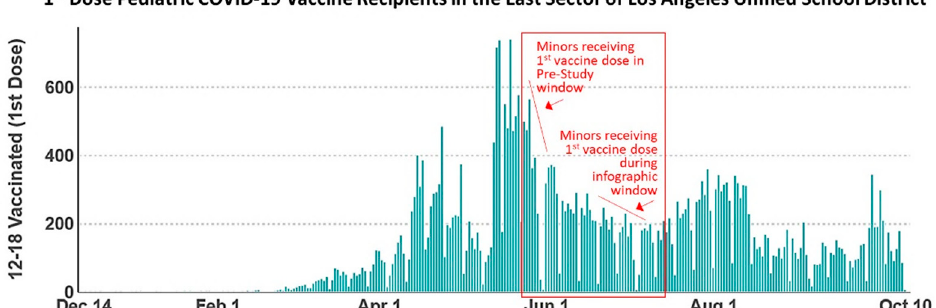
Figure 4. Data from the Los Angeles County Department of Public Health mined from the Com- munity School District Data Explorer showing numbers of first-dose pediatric COVID-19 vaccine recipients in the East sector of the Los Angeles Unified School District. Pediatrics scheduled for the second COVID-19 vaccine doses during the pre-study window received a first vaccine dose between 24 and 28 May, marked on the graph accordingly. Pediatrics scheduled for the second COVID-19 vaccine dose during the effect period of the study received a first vaccine dose between 21 June and 9 July while COVID-19 vaccine infographics were being distributed, also marked on the graph accordingly. The data show a general declining trend in the numbers of pediatric COVID-19 vaccine recipients throughout the duration of this